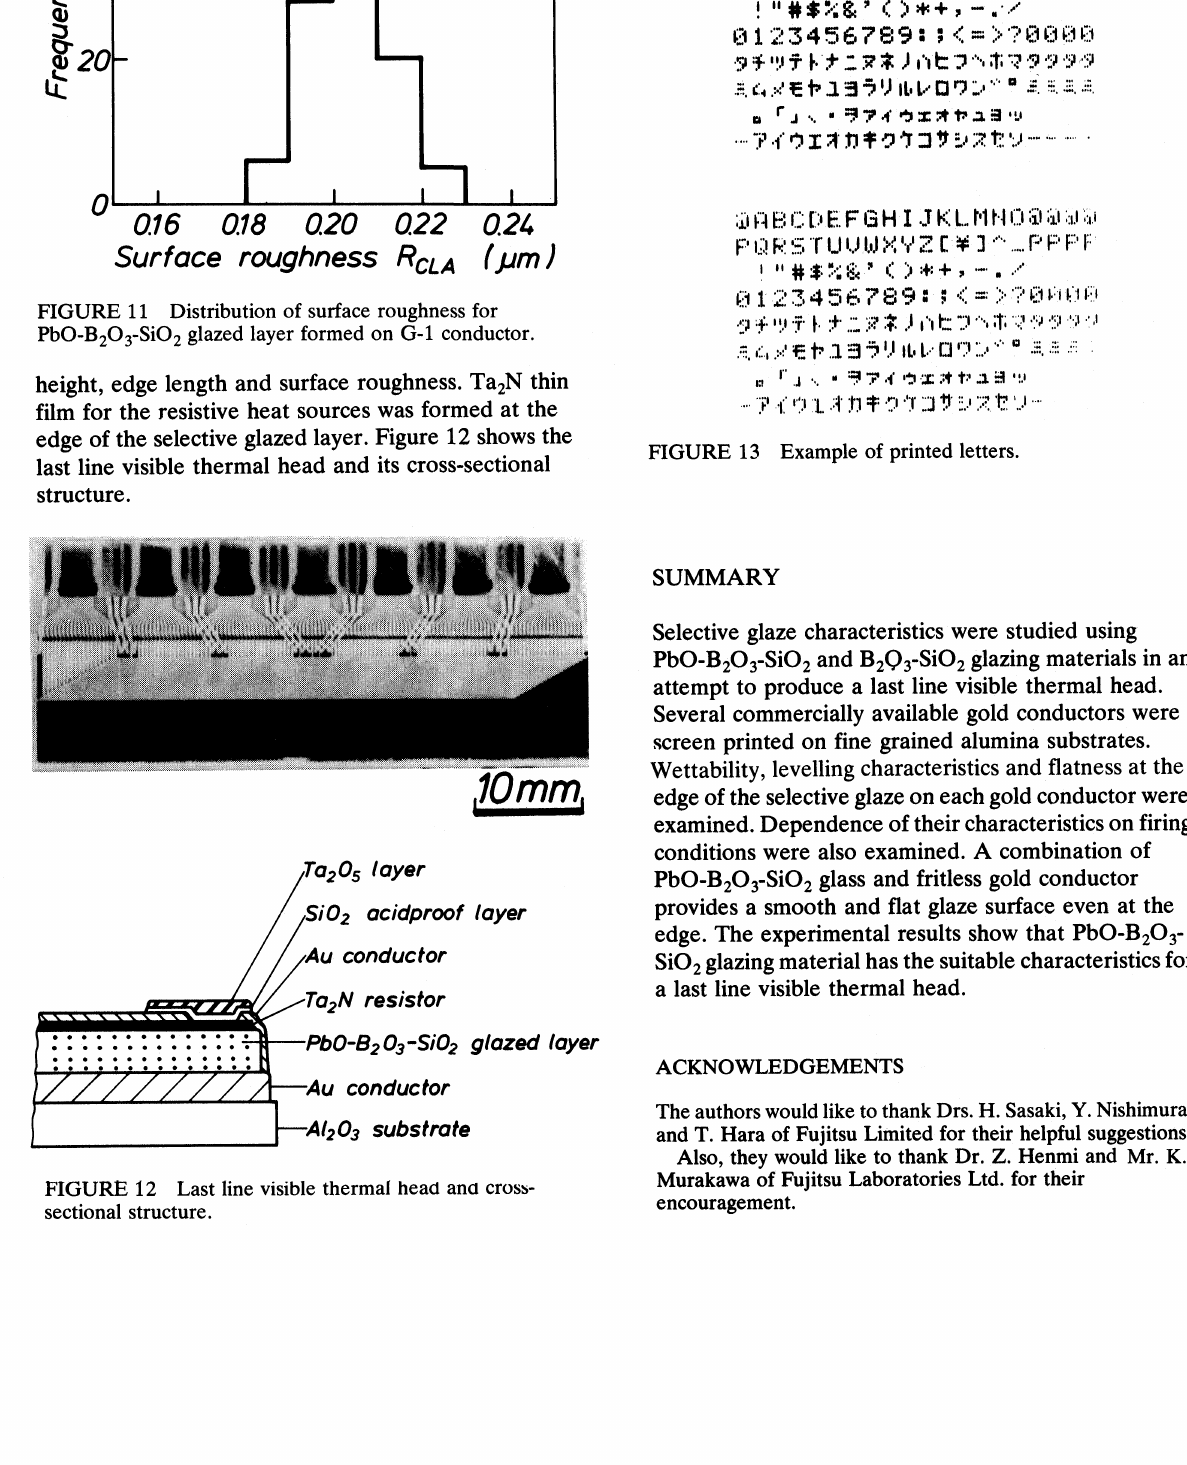
FIGURE 13 Example of printed letters.